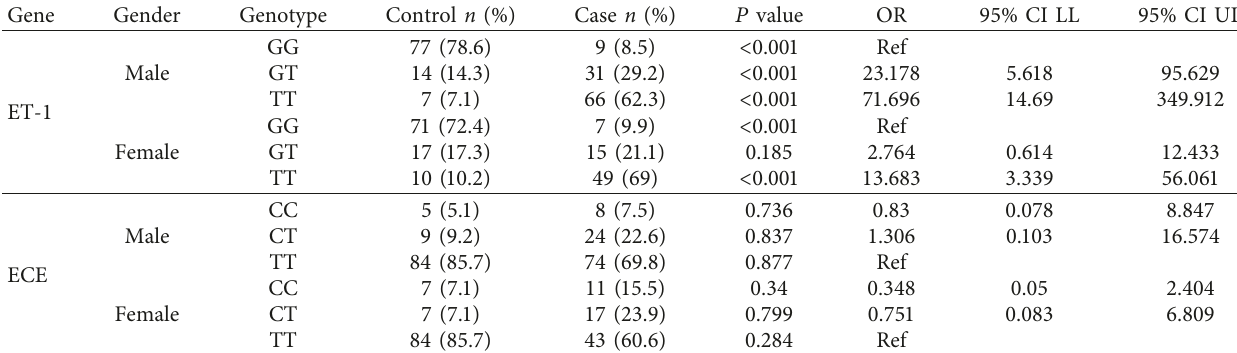
Table 6: Genotypic distribution in female and